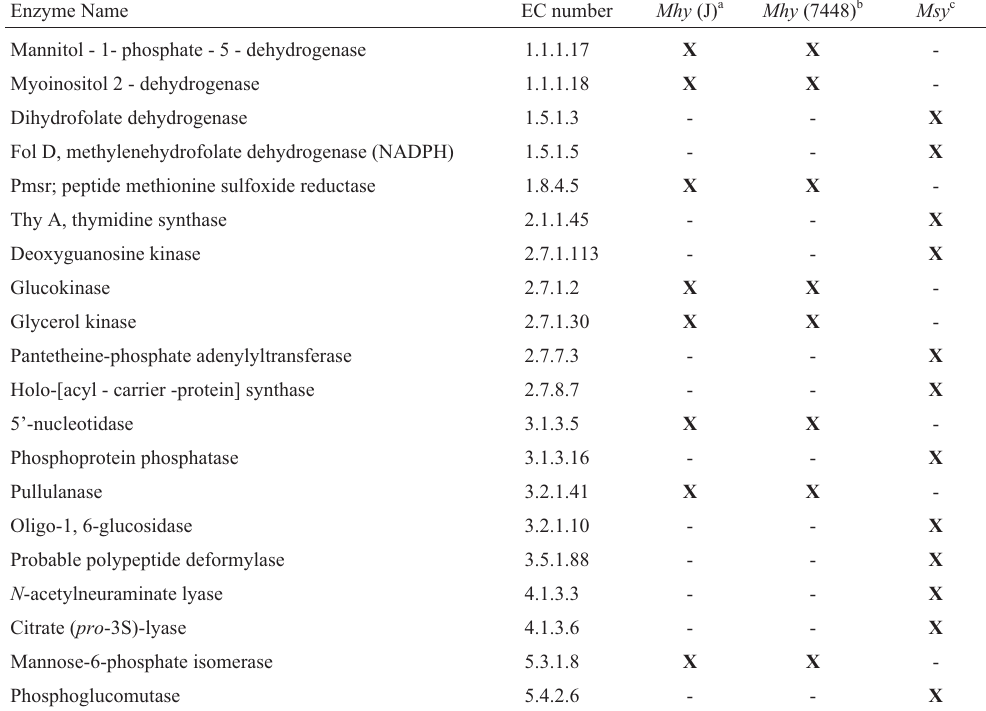
Table 1 - Differential sequences encoding enzymes of Mycoplasma hyopneumoniae (strains J and 7448) and Mycoplasma synoviae